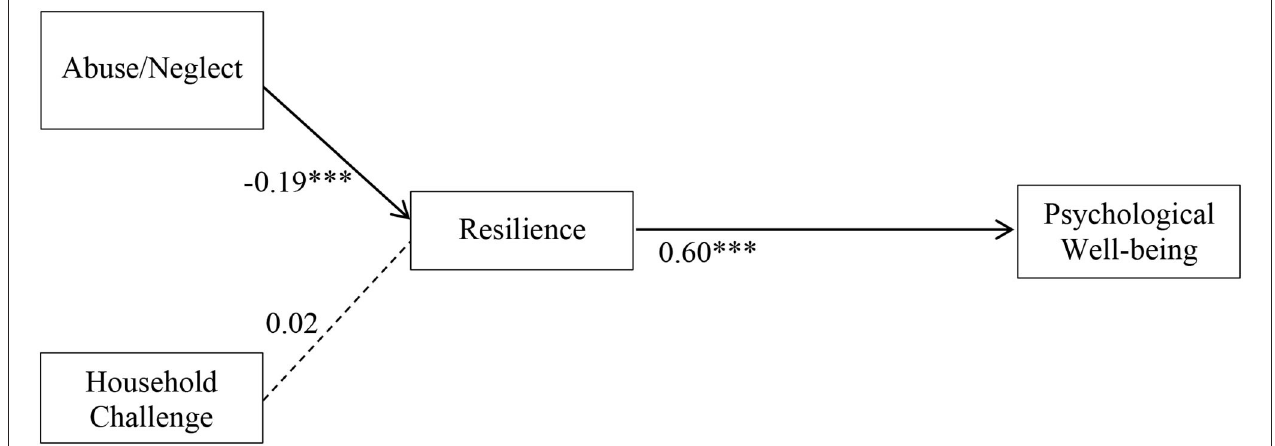
FIGURE 2 | Structural equation modeling of ACE dimensions on resilience and psychological well-being for females. N = 1,871. *** p < 0.001. Solid line, significant standardized path coefficient; Dotted line, non-significant standardized path coefficient.